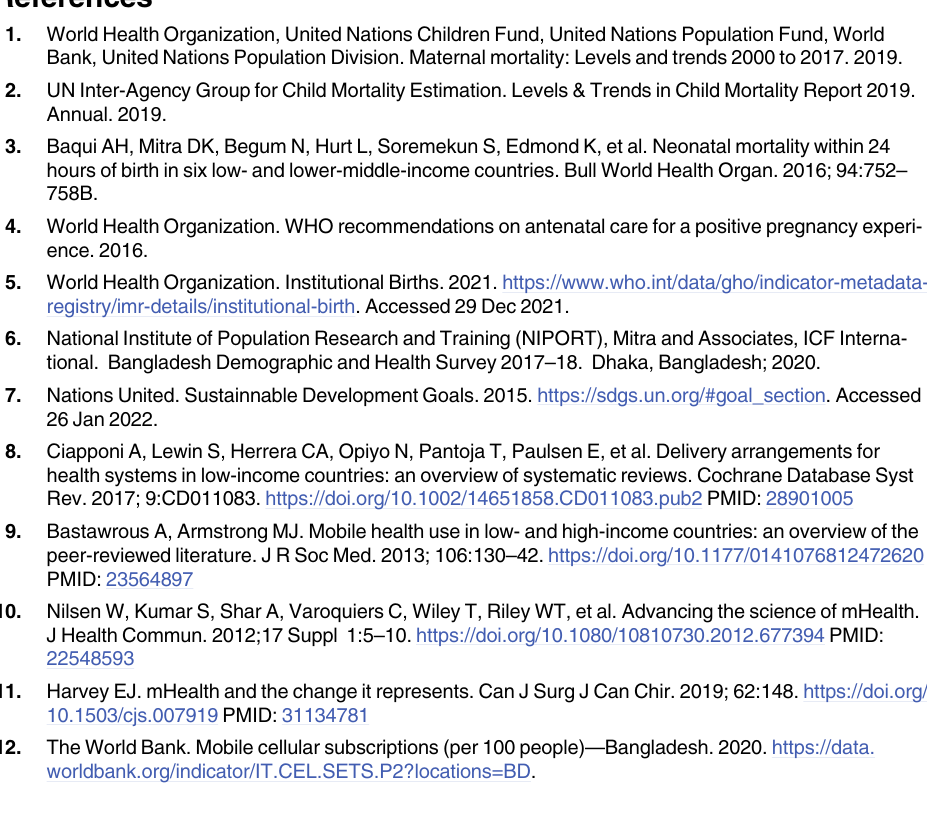
S1 Fig. Flow diagram of the data extraction process. S2 Fig. Conceptual framework for the relationship of mobile phone use with antenatal care visits and hospital delivery.